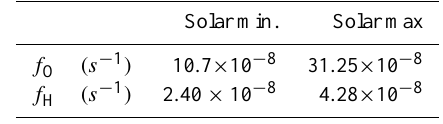
Table 1. Photoionization frequencies near Mars orbit for oxygen and hydrogen atoms as a function of the solar activity. Solar min. Solar